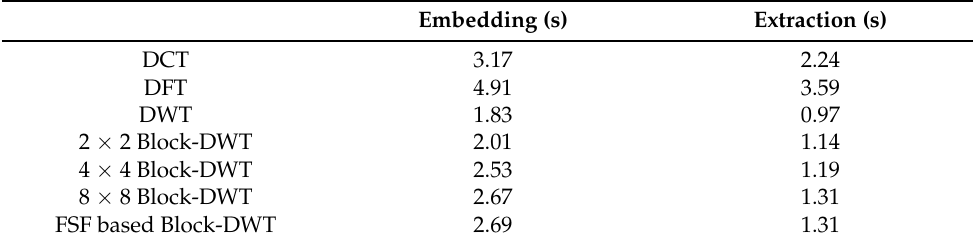
Table 4. CPU times in embedding and